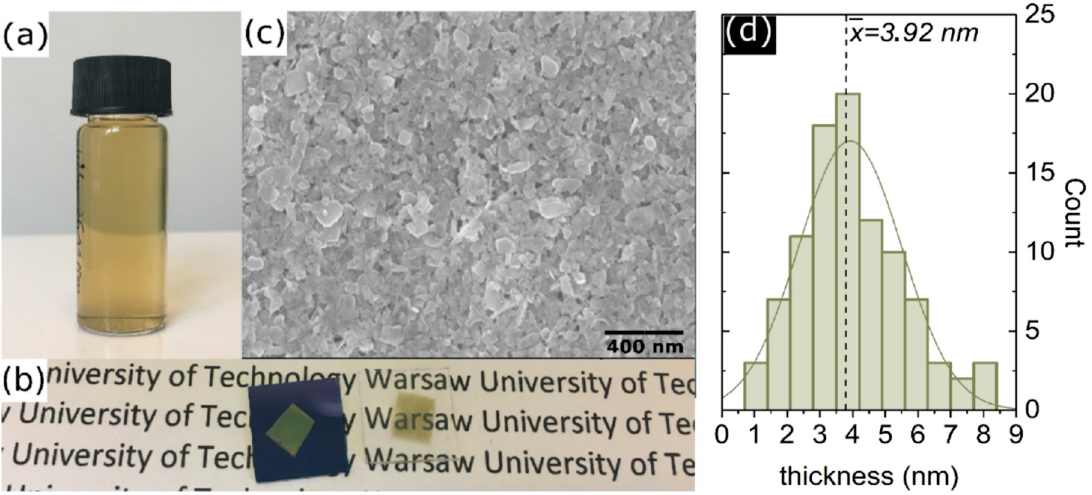
Figure 1. ( a ) Suspension of tungsten disulfide made via “green” liquid exfoliation, ( b ) thin films of WS 2 fabricated using vacuum filtration on Si/SiO 2 and glass substrates, ( c ) SEM scan of fabricated thin films, ( d ) flakes thickness distribution, based on AFM study.